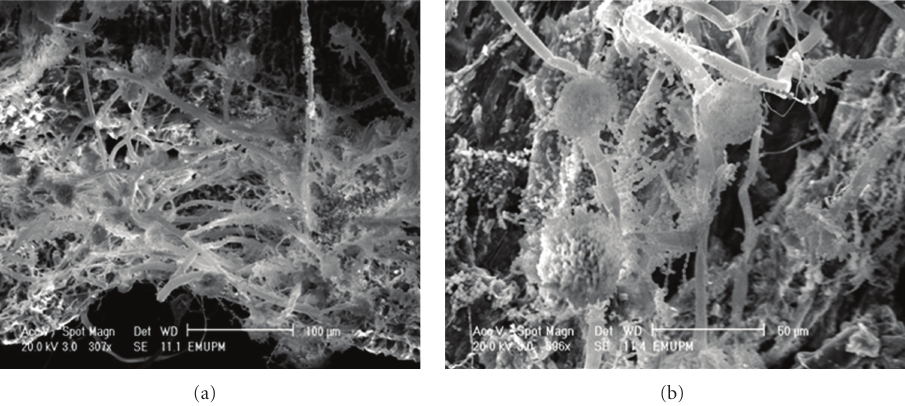
Figure 8: Scanning electron micrographs of A. Terreus ATCC 20542 (a) and A. Terreus ATCC 75135 (b) on the surface of RS. High concentration of mycelium and spore could have negative e ff ects on air flow in the solid